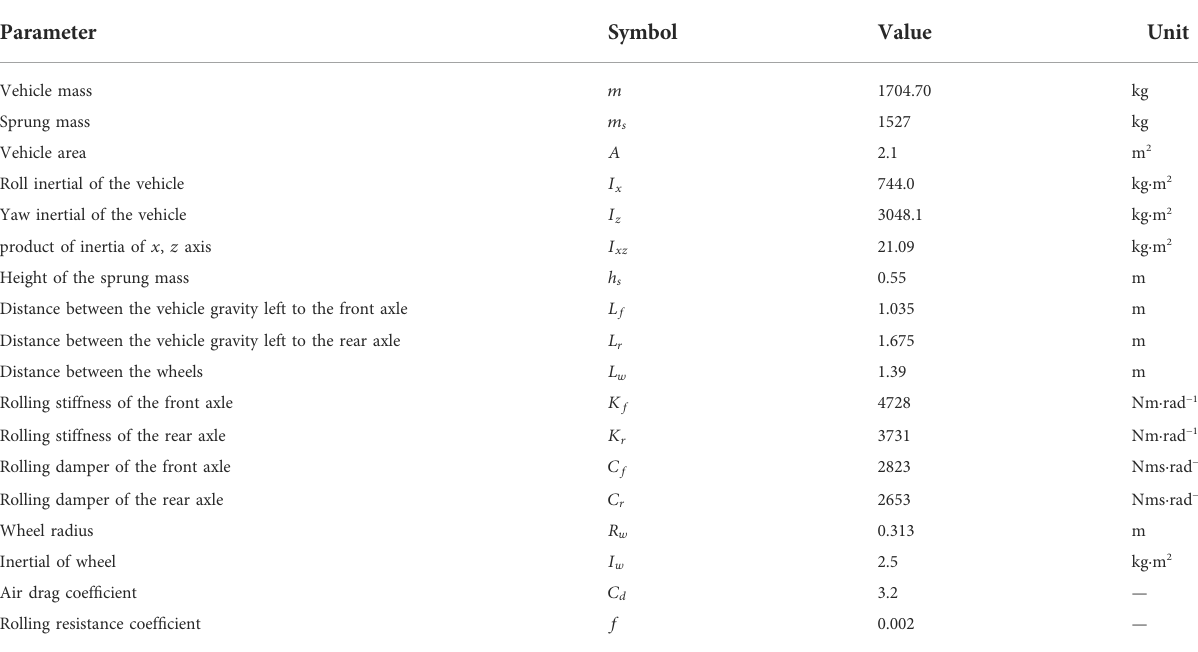
TABLE 1 Vehicle parameters. Parameter Symbol Value